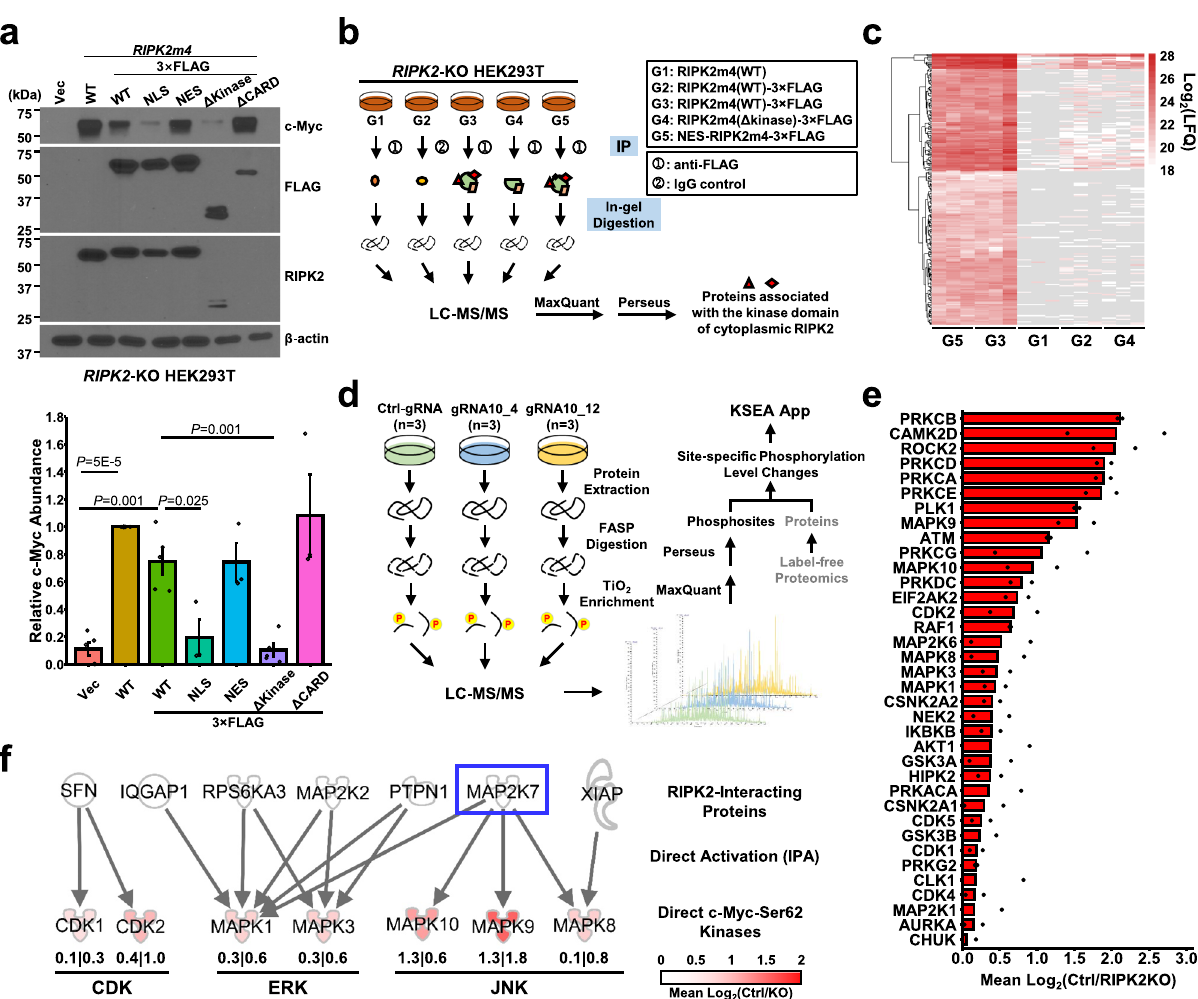
Fig. 5 Integrative proteomics analysis identi fi es candidate kinase pathways mediating RIPK2 phosphorylation of c-Myc-S62. a Representative immunoblots (upper) and quanti fi cation (lower) of c-Myc in RIPK2 -KO HEK293T cells transiently transfected with the indicated plasmids (n = 5 biologically independent samples per group, excepting for n = 3 biologically independent samples in the Δ CARD group). Nominal p- values were determined by unpaired two-tailed Student ’ s t -test. Data are shown as Mean ± SEM. WT: wild-type; NLS: nuclear localization signal; NES: nuclear export signal; Δ kinase: deletion of the kinase domain; Δ CARD: deletion of the CARD domain. b Schematic of the IP-MS-based interactome analysis. RIPK2 -KO HEK293T cells were transiently transfected with the indicated forms of plasmids (shown in the upper right box). Protein complexes were immunoprecipitated using an anti-FLAG